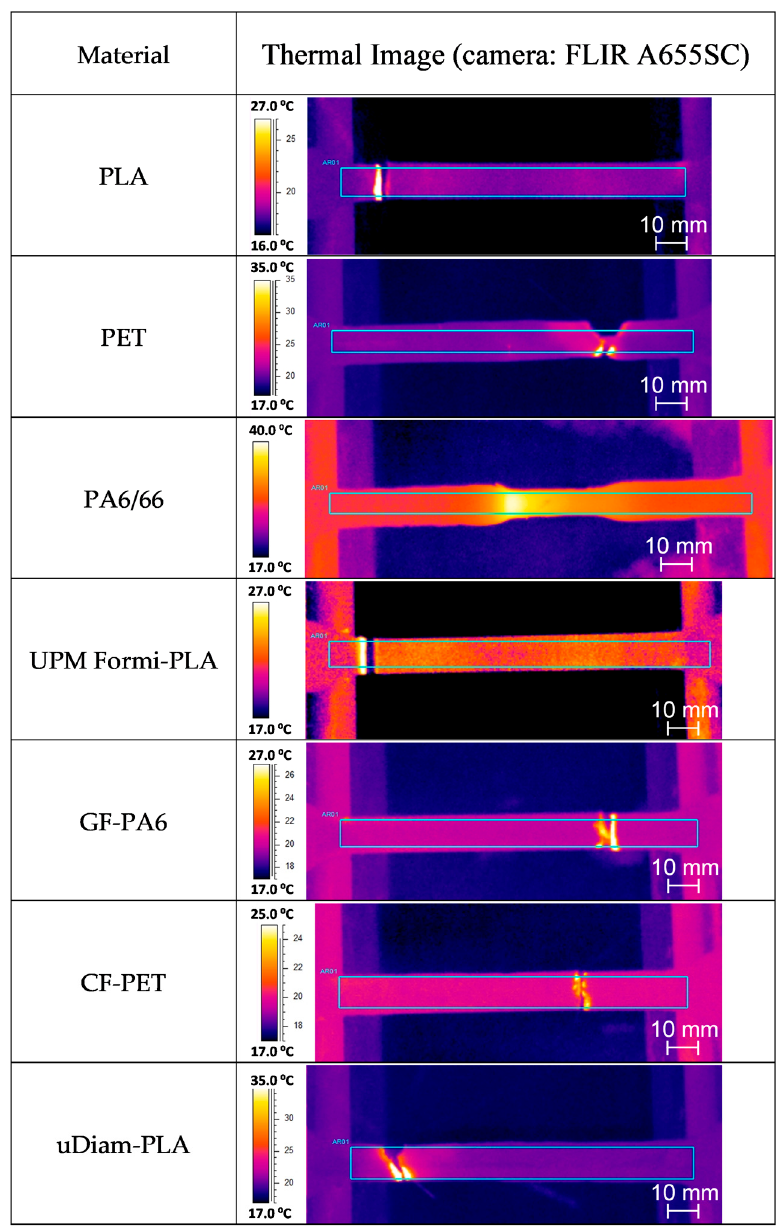
Figure 6. Infrared thermography for some of the investigated specimens.